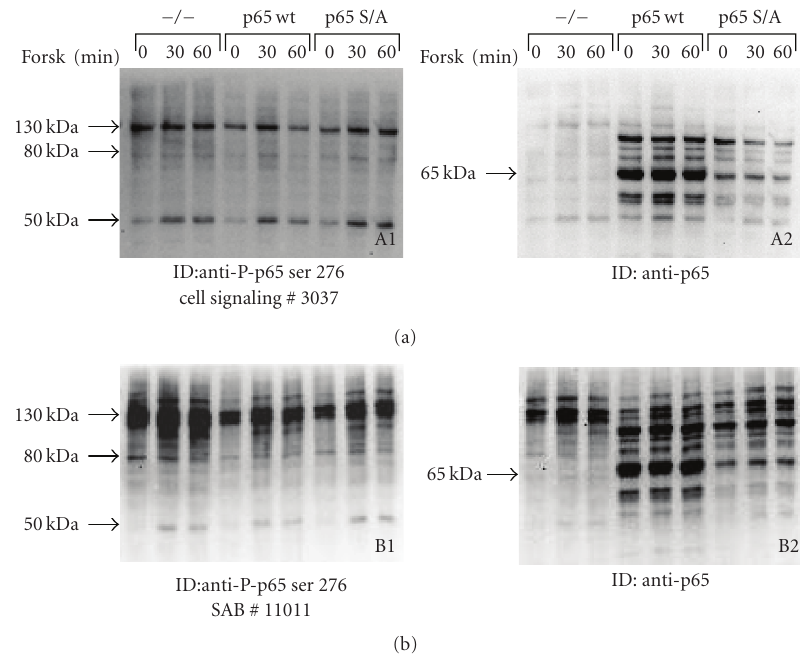
Figure 4: Presence of anti-P-p65 Ser276-reactive bands in p65 deficient MEF cells. p65 knock-out MEF cells ( − / − ), or p65 − / − MEF cells reconstituted with wild type p65 (p65 wt) or p65 with Ser276 mutated to alanine (p65 S/A), were induced with forskolin (forsk, 10 μ M) for 0, 30, and 60 min. Presence of Ser276-phosphorylated p65 in cell lysates was analysed by Western Blot using Cell Signaling no. 3037 (A1) or SAB no. 11011 (B1). Blots were extensively washed and reprobed with anti-p65 to confirm p65 absence in − / − MEFs, and p65 presence in wt and S/A reconstituted MEFs (A2 and B2, arrows indicate anti-p65 detected bands).